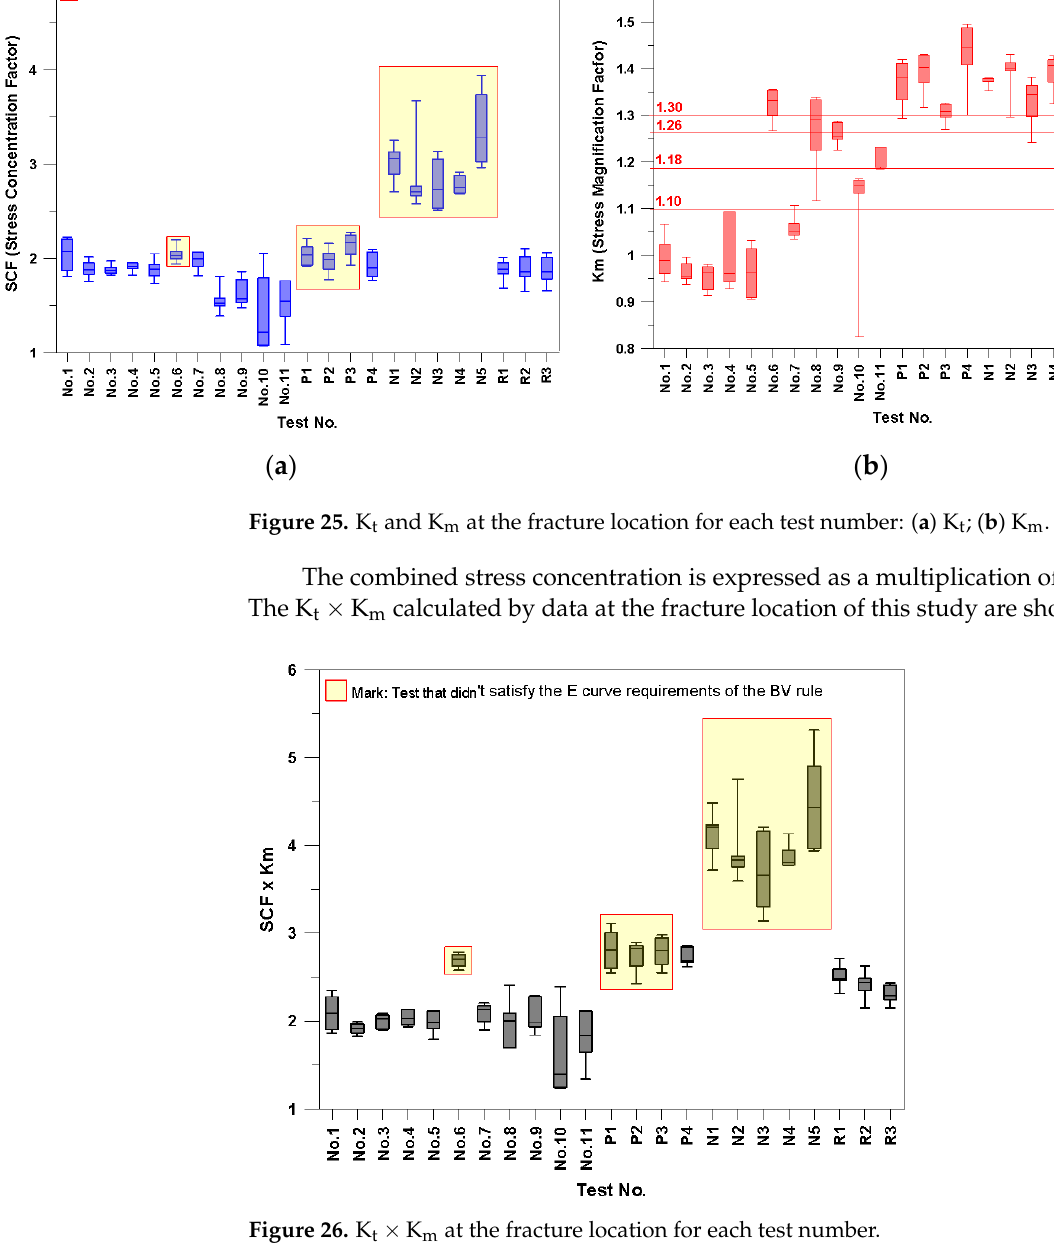
Figure 26. K (cid:2930) × K (cid:2923) at the fracture location for each test number. Figure 26. K t × K m at the fracture location for each test A value of 2.6 for K (cid:2930) × K (cid:2923) can be used as a borderline SCF to confirm whether the